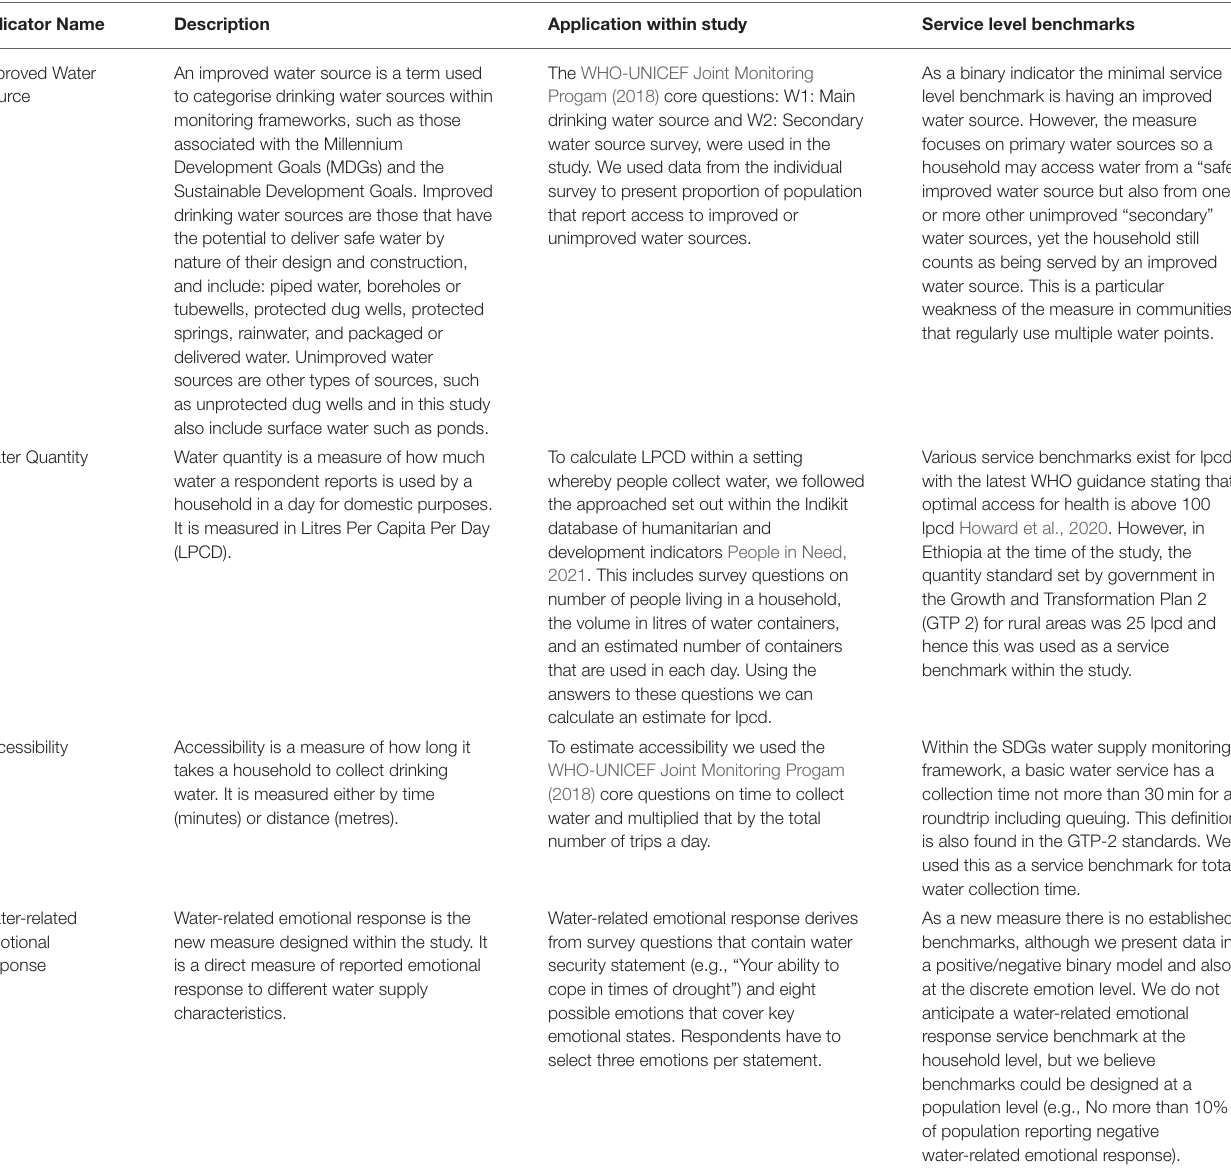
TABLE 1 | Water supply monitoring indicators and key